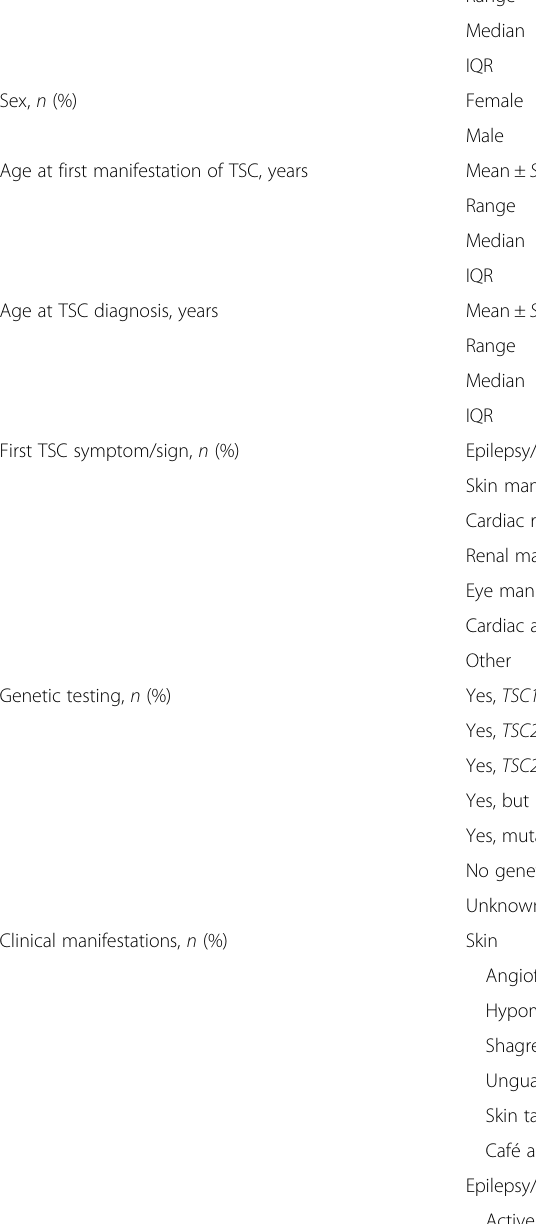
Table 1 Sociodemographic and clinical characteristics of participants ( n = 121)